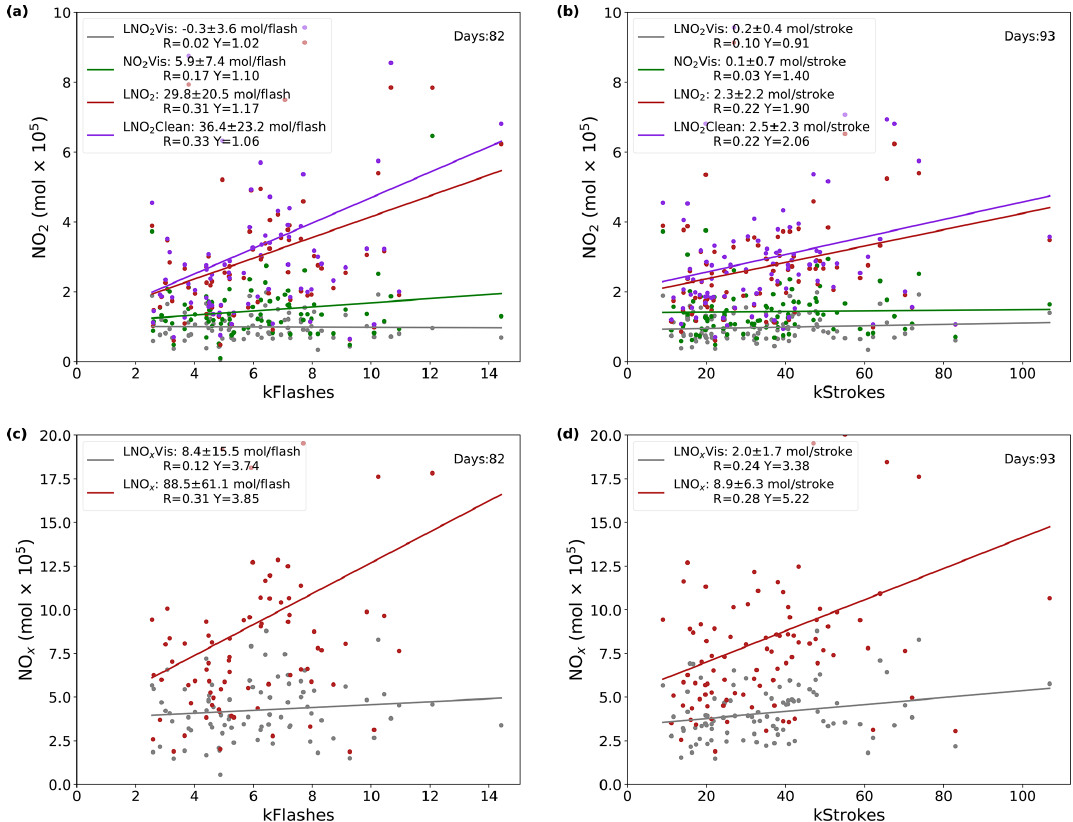
Figure 9. Same as Fig. 4 except for the 2 × 500molNO per flash